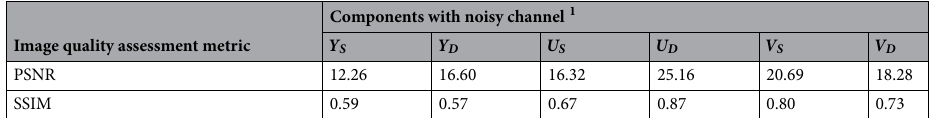
Table 10. The quality of the reconstructed image when one component is transmitted in the binary symmetric channel. The experimental results are obtained on the DRIVE dataset.